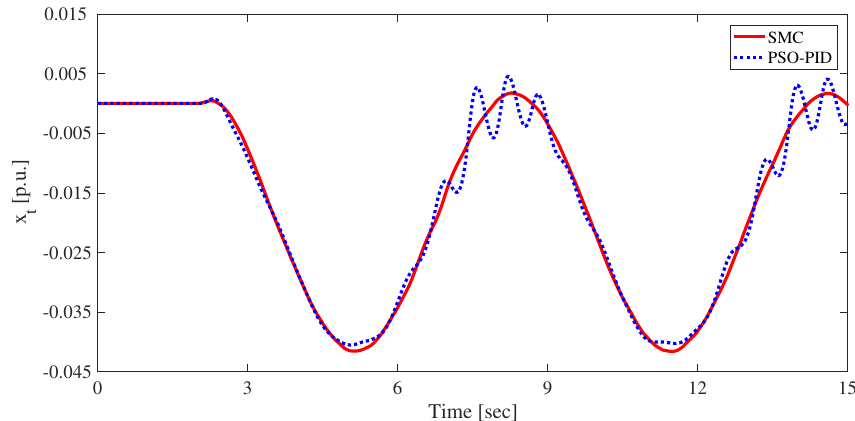
Figure 15. The time waveforms of x t under system uncertainties and random